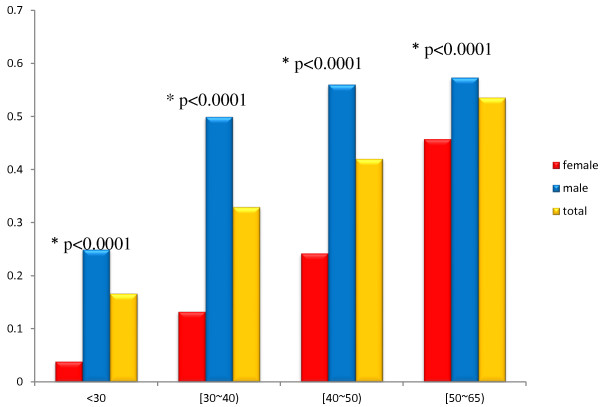
Age-specific prevalence of NAFLD. The prevalence of NAFLD increased according to age(trend chi-square value = 23.7292, p < 0.0001in total; chi-square value = 15.4859, p < 0.0001in male; trend chi-square value = 19.0515, p < 0.0001in female). The peak prevalence was in the 50-65 age group, up to 54% persons had NAFLD in total. The prevalence of NAFLD in males was significantly higher than females within the same age group (25% vs 3.89% in younger than 30- year old age group, 50% vs 13.29% in 30-39 age group, 56.06% vs 24.27% in 40-49 age group, and 57.35% vs 45.79% in 50-64 age group). In female, the prevalence increased dramatically after 50 years old. *The contraction between male and female in the same age group, p < 0.0001.